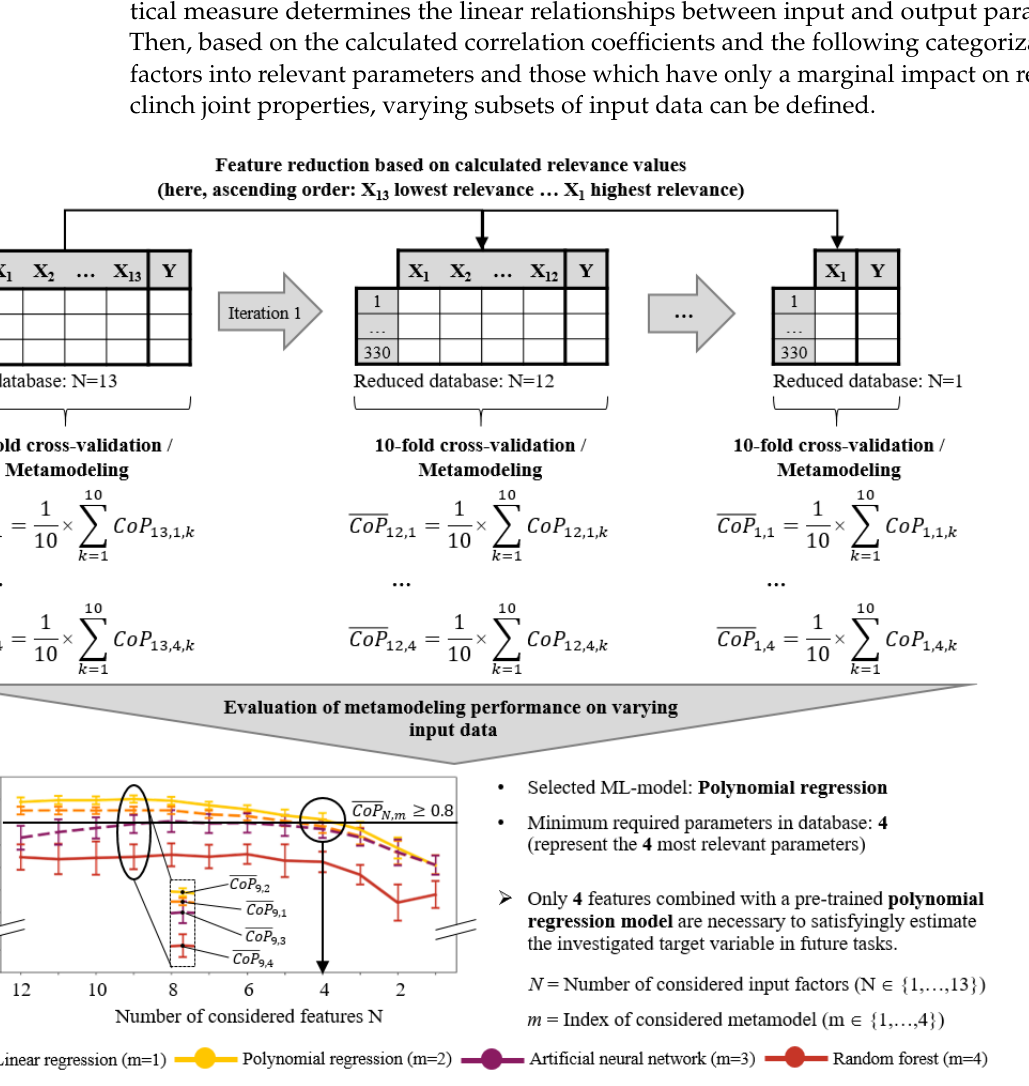
Figure 4. Process of the feature-selection